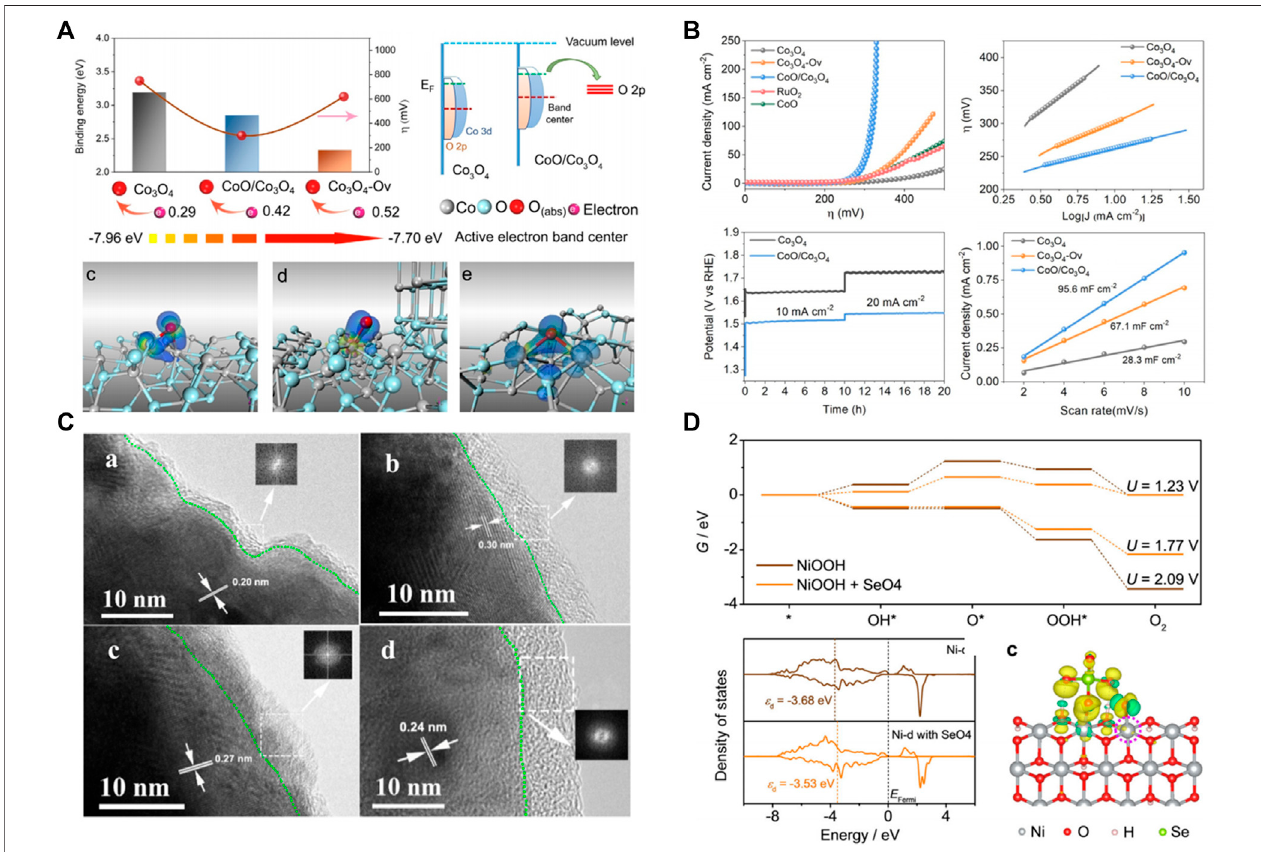
FIGURE 2 | (A) DFT calculations of Co 3 O 4 , CoO/Co 3 O 4 , and Co 3 O 4 -Ov. (B) Electrochemical catalytic measurement of OER on Co 3 O 4 , Co 3 O 4 -O v , CoO/Co 3 O 4 , CoO, and RuO 2 . (C) HRTEM images of postcatalysis samples of Ni, Ni 3 Se 2 , NiSe, and NiO. (D) DFT calculations of NiOOH and NiOOH + SeO 4 indicate that the adsorption of